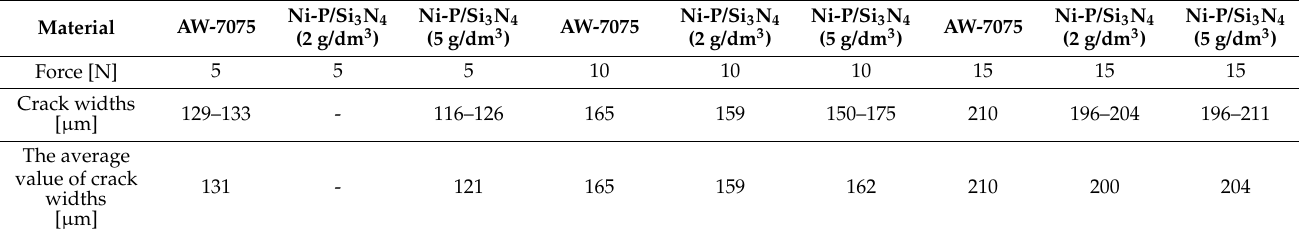
Table 10. Crack widths after tribological